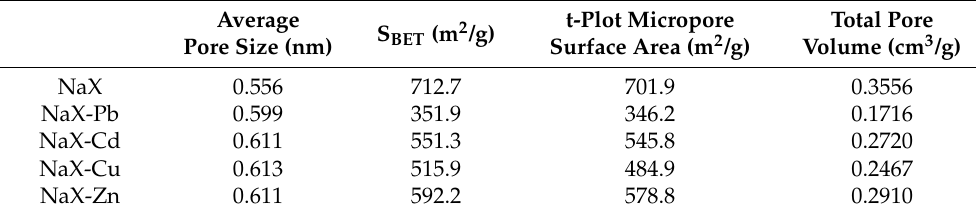
Figure 6. Infrared spectra ( a ) and pore size distribution ( b ) of NaX, NaX-Pb, NaX-Cd, NaX-Cu and NaX-Zn. Table 6. The BET specific surface area (S BET ) and pore parameters of NaX, NaX-Pb, NaX-Cd, NaX-Cu and NaX-Zn